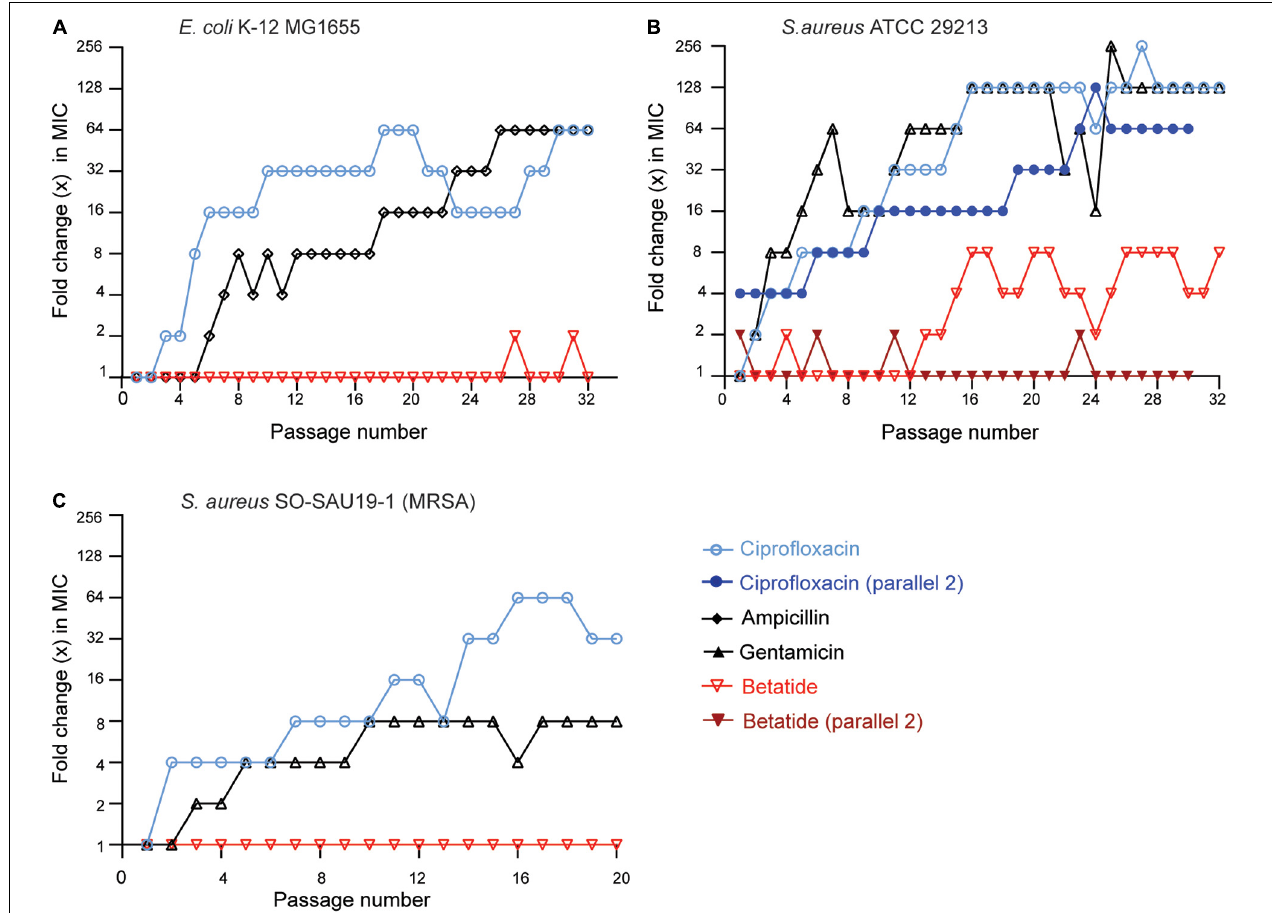
FIGURE 3 | Low ability for bacteria to develop resistance against betatide after serial passages in media containing sub-MIC levels of betatide. Increase in MIC relative to day 1 in (A) E. coli K-12 MG1655, (B) S. aureus ATCC 29213, and (C) S. aureus SO-SAU19-1 (MRSA) after exposure to sub-MIC-level (0.25 × and 0.5 × ) betatide and two reference antibiotics over 20–32 days. The bacteria were serial passaged every day with fresh media and treated with new doses of ciprofloxacin (blue circles), ampicillin (black diamonds) or gentamicin (black upright triangles), and betatide (red inverted triangles) to determine new MICs. Two independent experiments are shown for ciprofloxacin and betatide for S. aureus ATCC 29213 where parallel 2 is shown as darker shades of filled blue circles and filled red inverted triangles,